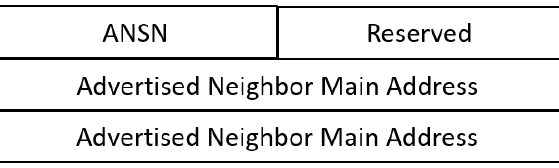
Figure 3. TC Message Format (RFC